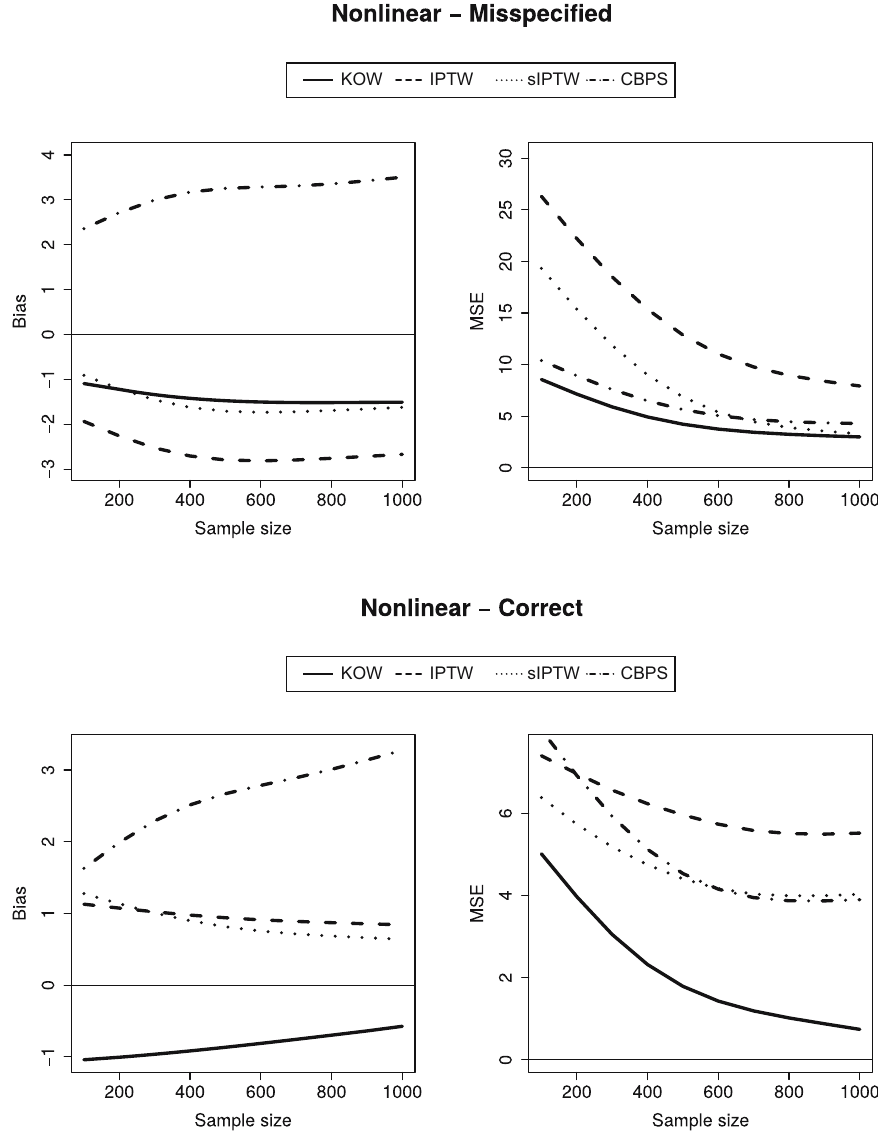
Figure 2: Bias and MSE of the estimated time - varying treatment e ff ect using KOW ( solid ) , IPTW ( dashed ) , sIPTW ( dotted ) , and CBPS ( dashed - dotted ) when increasing the sample size from n 100 = to n 1,000 = , in the nonlinear - misspeci fi ed scenario ( top panels ) and in the nonlinear - correct scenario ( bottom panels )